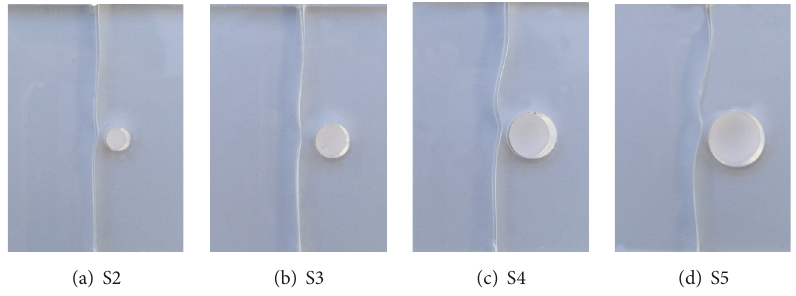
Figure 4: Fracture forms of specimens.